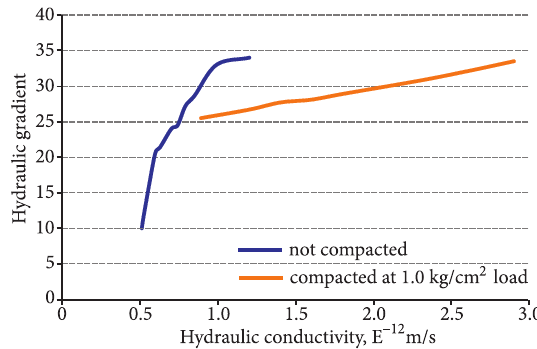
Fig. 8. Dependence on the hydraulic gradient and the hydraulic conductivity of clay